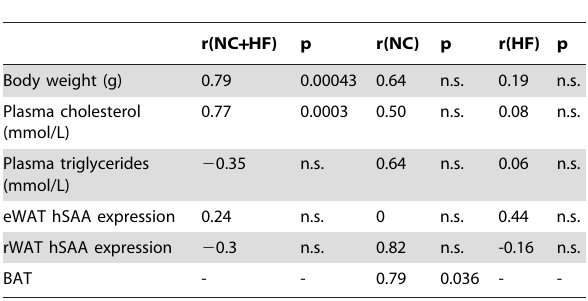
Table 2. Spearman correlation coefficients (r) between hSAA plasma levels, body weight, and plasma lipids in hSAA male